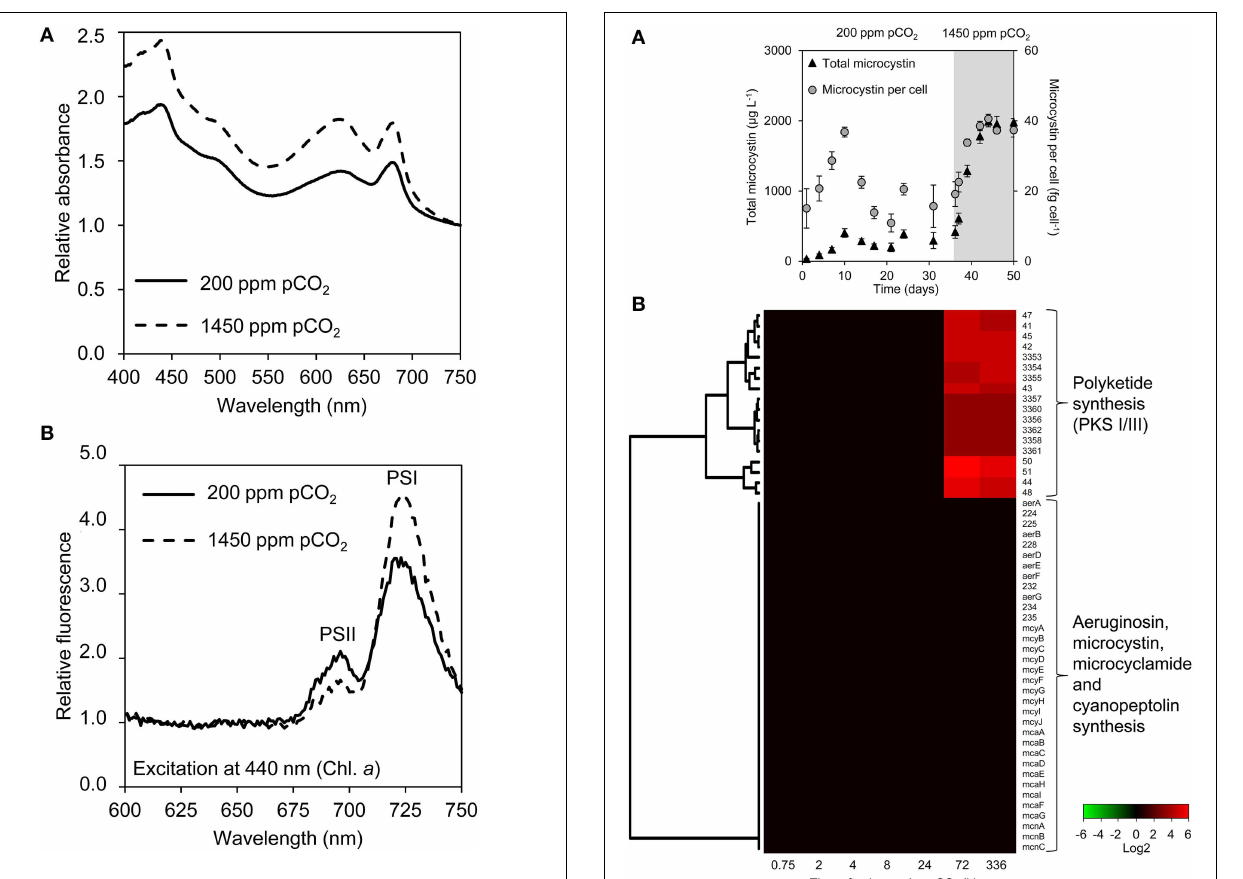
FIGURE 3 | Light absorption and emission spectra of cells grown at low pCO 2 (200ppm) and high pCO 2 (1450ppm). (A) Light absorption spectra normalized at 750nm, with peaks of chlorophyll a (436 and 678nm), β -carotene (shoulder at 490nm) and phycocyanin (626nm). (B) 77 K fluorescence emission spectra normalized based on the mean emission at 600–660nm, with peaks of PSI (720nm) and PSII (695nm). The spectra are the average of four biological replicates.